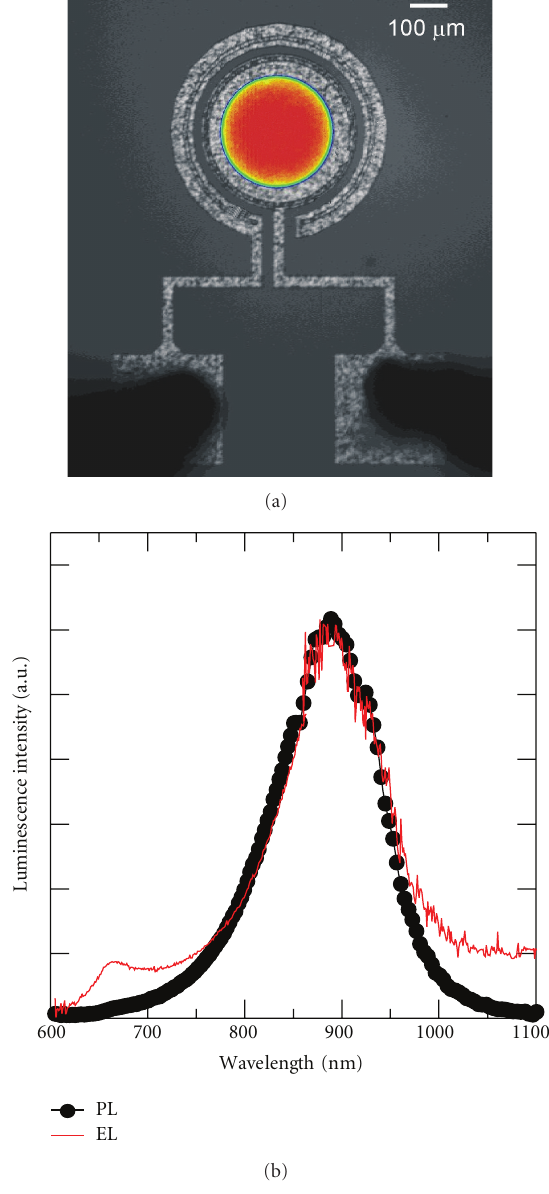
Figure 12: (a) EMMI image of a device based on Si-nc. The colors indicate di ff erent intensities of the emitted light, red being the highest. (b) Comparison between the PL and the EL spectra of the